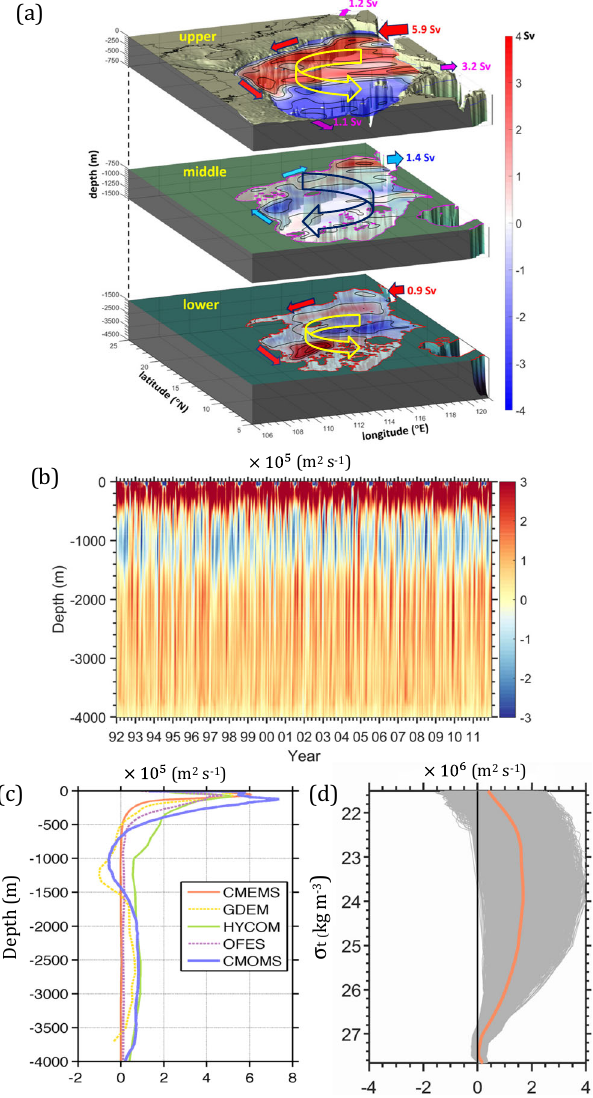
Fig. 1 Characteristics of the layered circulation in the SCS. a Schematic annual mean cyclonic-anticyclonic-cyclonic (CAC) circulation in the upper ( h ≤ 750m), middle (750m< h ≤ 1500m) and deep layers ( h >1500m) of the SCS, respectively, based on CMOMS. The color contours represent transport (Sv) stream function. The arrows and transports (Sv) along the periphery of the SCS indicate the climatological mean volume transports through Taiwan Strait, Mindoro Strait, Karimata Strait, and Luzon Strait. b The 20-year time series of domain-integrated depth-dependent relative vorticity in the SCS basin. c Vertical pro fi le of the 20-year time domain-integrated relative vorticity obtaining from geostrophic currents based on hydrographic data from GDEM (Generalized Digital Environmental Model; yellow dashed line), global models of CMEMS (The European Copernicus Marine Environment Monitoring Service; solid orange line), HYCOM (Hybrid Coordinate Ocean Model; green solid line) and OFES (Ocean General Circulation Model For the Earth Simulator; purple dashed line), and CMOMS (China Sea Multi-scale Modeling System; blue solid line) as a function of depth. Note, the data were averaged from 1991to 2010. d Vertical pro fi le of domain-integrated depth-dependent relative vorticity relative to isopycnal coordinates (gray lines) and their mean values (orange line) from 1992 to